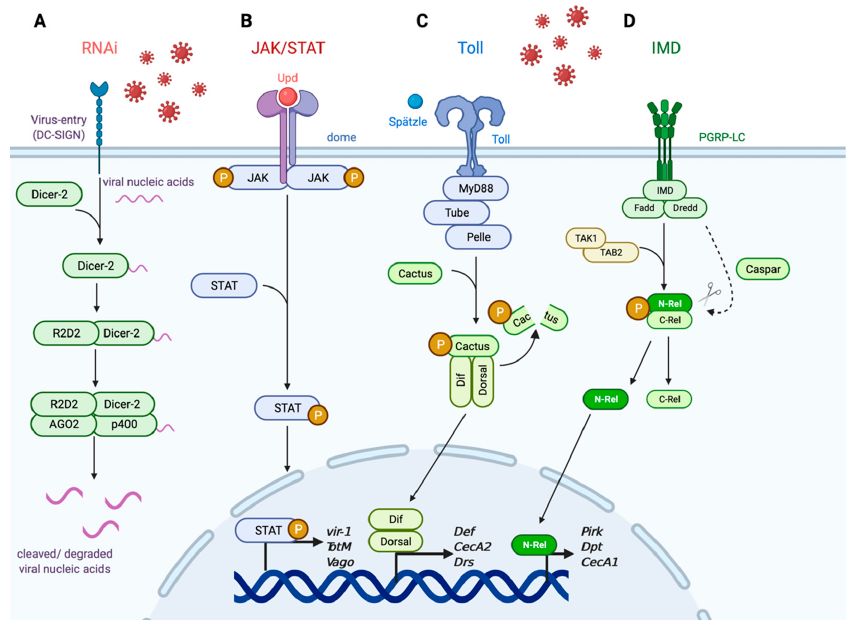
Figure 1. Innate immune signaling in insect and mosquito systems. The innate immune system is heavily conserved across species and involves various signaling pathways induced in response to viral nucleic acids (RNAi) or detection of upstream antiviral effectors (JAK/STAT, Toll, IMD). ( A ) The RNA interference (RNAi) pathway functions to detect cytosolic dsRNA or DNA that is indicative of viral infection. ( B ) The JAK/STAT pathway, which is conserved between mosquito and human species, induces transcription of downstream antiviral effector genes. ( C ) The Toll pathway functions to respond to Gram-positive bacterial and fungal infection and is present in the form of TLR in mammals. ( D ) The IMD pathway is activated during Gram-negative bacterial infection and is similar Retrieved from https://app.biorender.com/biorender-templates